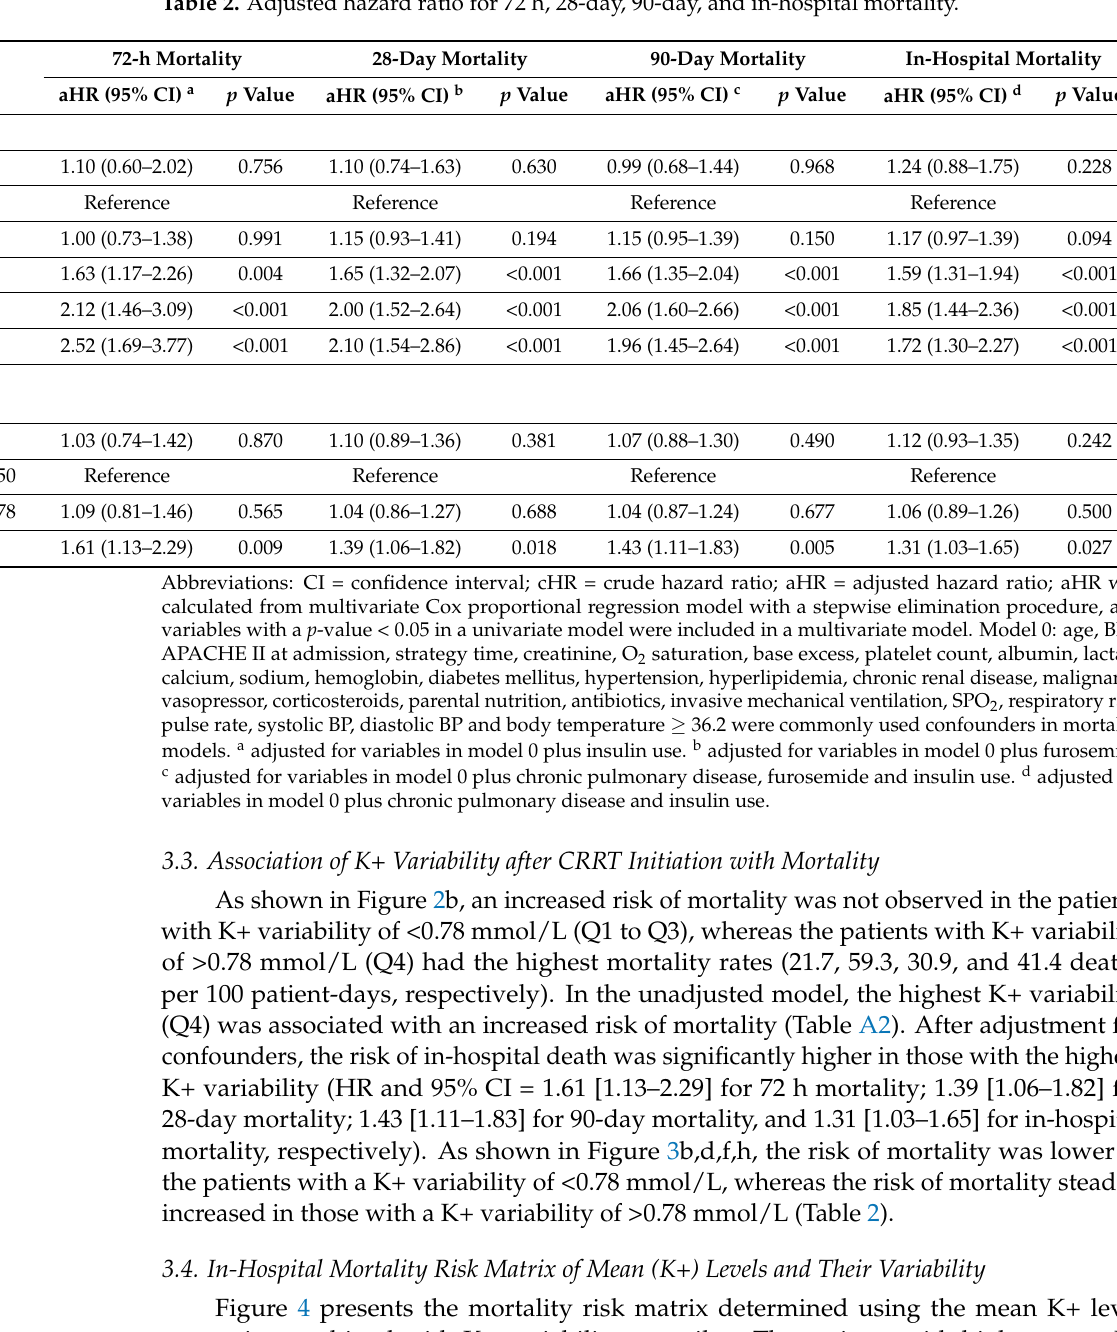
Table 2. Adjusted hazard ratio for 72 h, 28-day, 90-day, and in-hospital